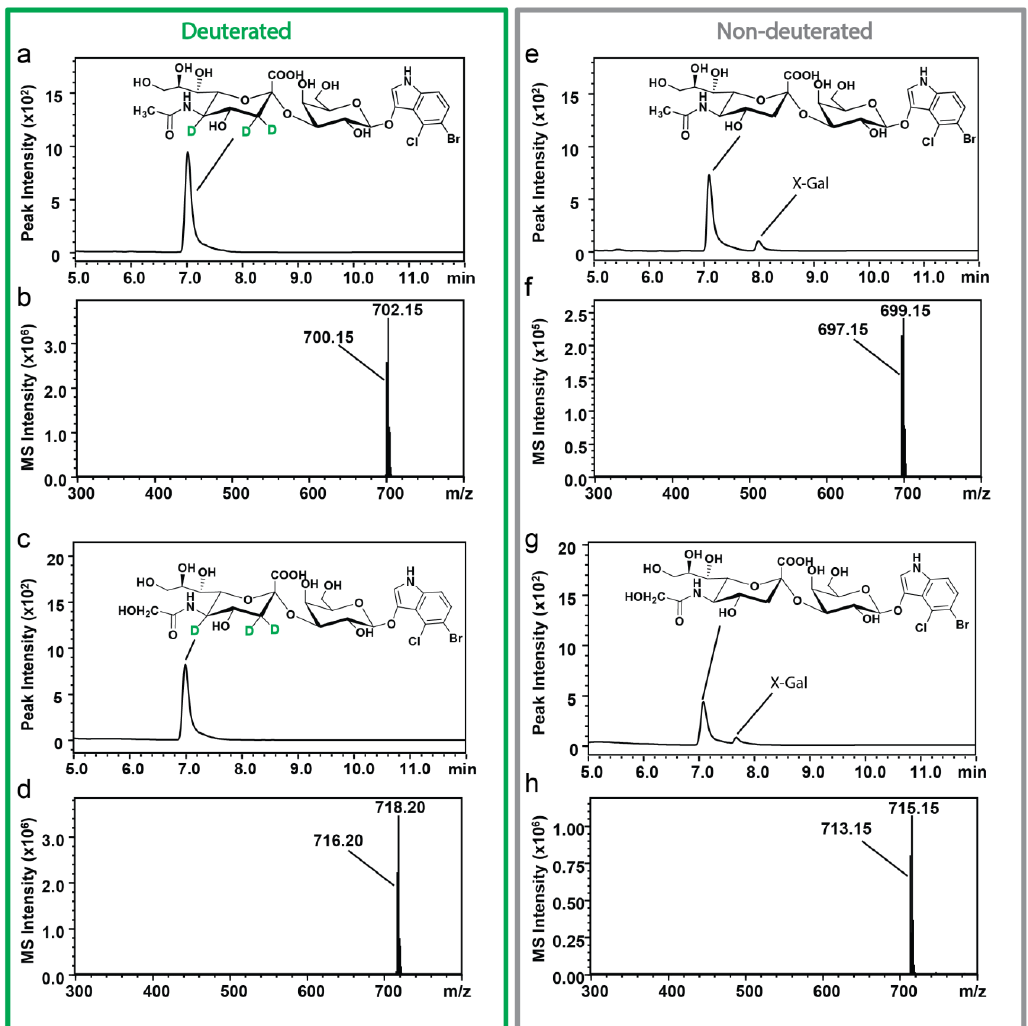
Figure 1. HPLC chromatograms (panels a , c , e and g ) and ESI-MS spectra (panels b , d , f and h ) of deuterated and non-deuterated sialosides. The UV absorbance was monitored at 300 nm.